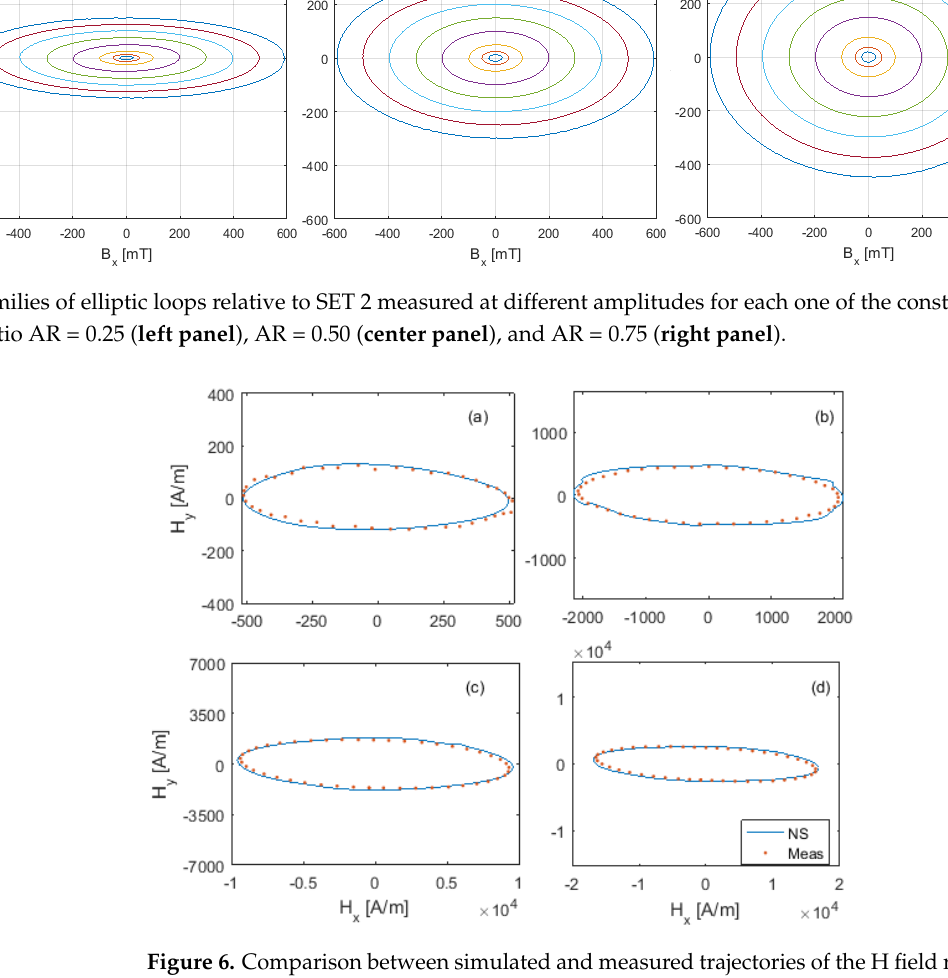
Figure 7. Comparison between simulated and measured trajectories of the H field relative to the elliptic loops, where AR = 0.50 for the following values of the major half-axis: Bx = 10 mT ( a ), Bx = 100 mT ( b ), Bx = 400 mT ( c ), and Bx = 600 mT ( d ).